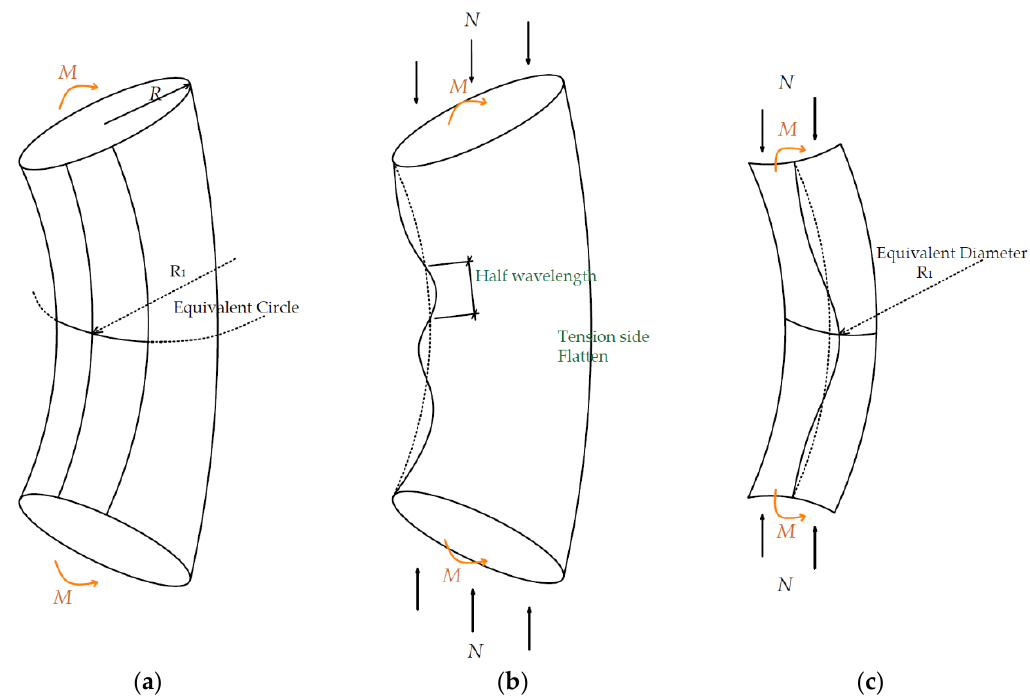
Figure 6. ( a ) Section ovalisation of a bending cylindrical shell; ( b ) the resulted effect of combined loads; and ( c ) the strip of a highly stressed shell segment.